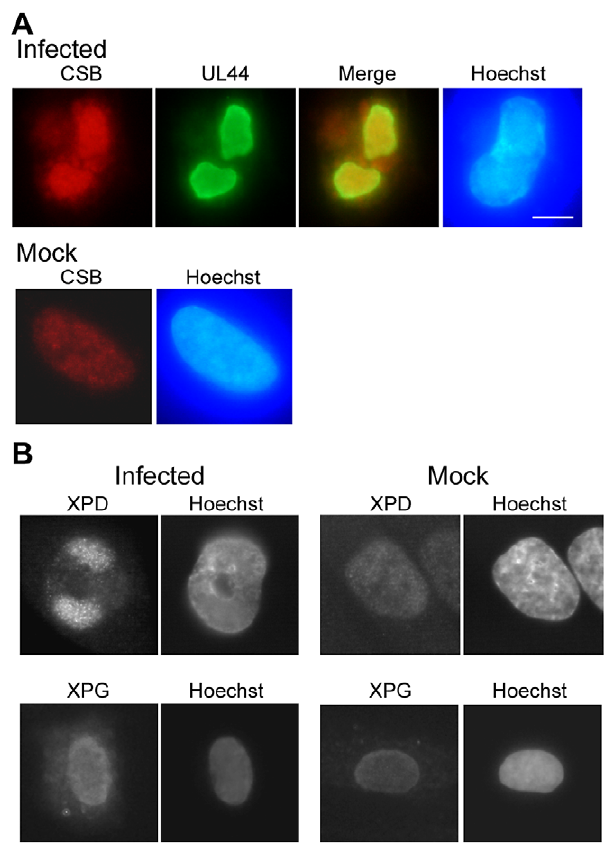
Figure 1. Certain NER proteins were tightly associated with HCMV RCs. A) HFFs were mock- or virus-infected at an MOI of 5 for 48 h and harvested for IF analysis. Coverslips were treated using extract-first conditions (as described in Materials and Methods) and then stained simultaneously for CSB (red) and the viral processivity factor, UL44 (green). Overlay of the two images shows almost complete overlap of the signals (indicating tight association of CSB) in the infected cells. Staining of mock-infected cells shows nuclear localization of CSB. DNA was counterstained with Hoechst (blue). Scalebar on all images=5 m m. B) Cells were stained for XPD (using ‘‘fix first conditions) in the top panels or for XPG (using ‘‘extract-first’’ conditions) in the bottom panels. Mock-infected cells again show nuclear localization of these antigens.